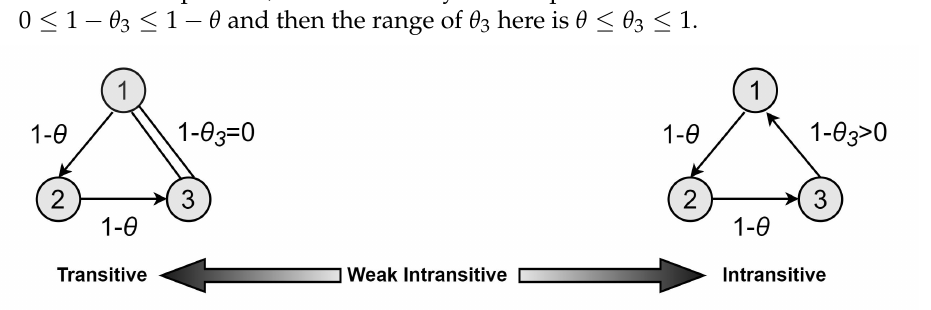
Figure 1. The spectrum of transitive–intransitive continuum in the three-species system. Arrows represent the net competition direction between two species, which point from the stronger to weaker competitor. Double lines represent equal net competition. From left to right, intransitivity 1 − θ 3 increases from 0 to 1 − θ , shifting a transitive network to an intransitive